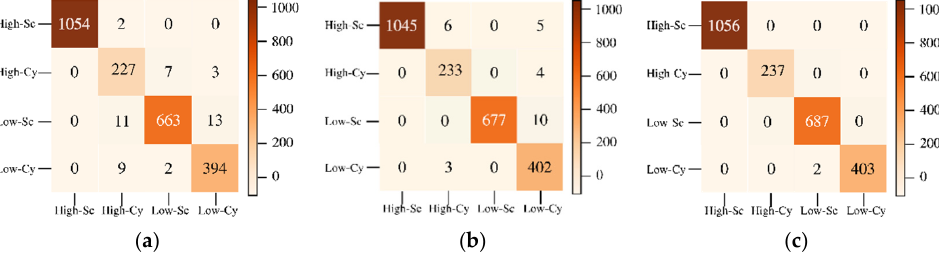
Figure 14. The confusion matrices for 4 labels High Scum, High Cynanobacteria, Low Scum, and Low Cyanobacteria pixels of the CyanoHAB image for three types of scaling- ( a ) normalization scaling (ns), ( b ) maximum scaling (ms), and ( c ) scaling (sc).